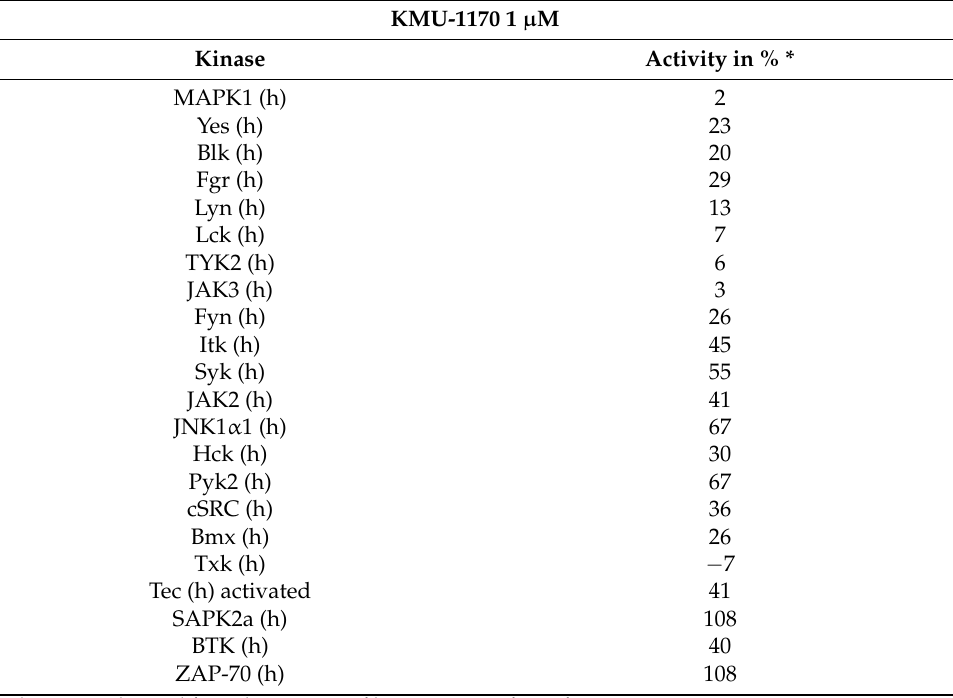
Table 1. Kinase activity of 15 protein kinases upon treatment with 1 µ M